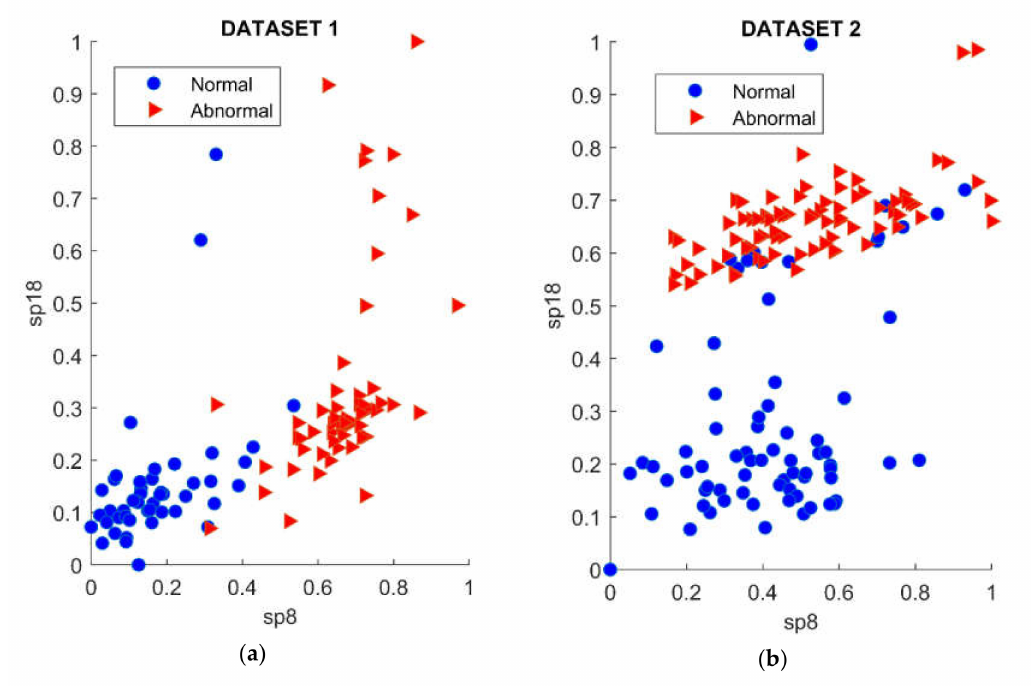
Figure 10. The distribution of data points according to the selected features corresponding to each leak case: ( a ) Leak size of 0.3 mm; ( b ) leak size of 2.0